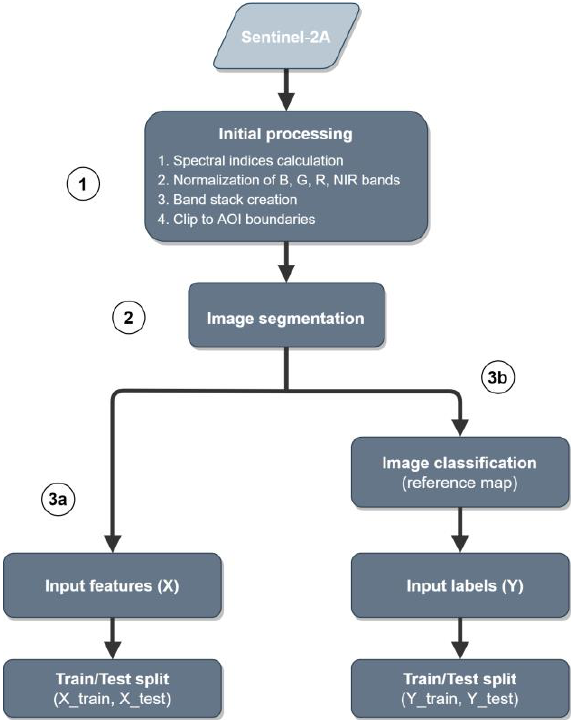
Figure 3 . Schematic diagram of data preparation.